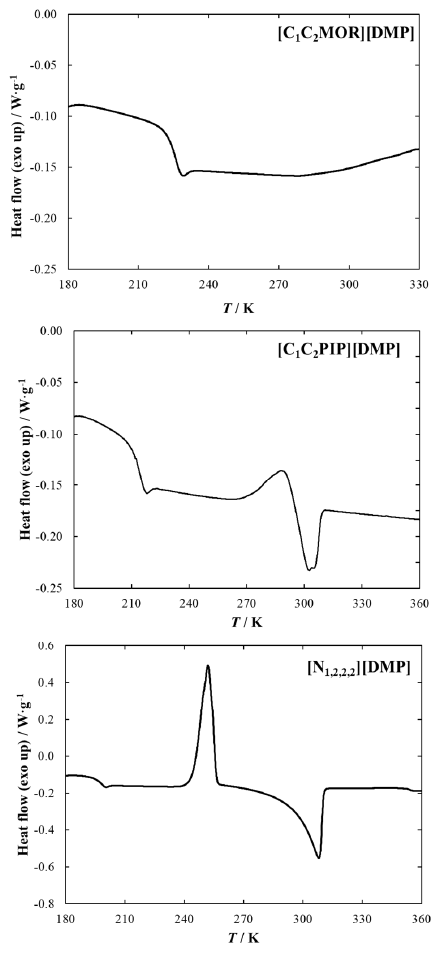
Figure 1. DSC diagrams (in heating mode) of pure iLs. Table 1. DSC Analysis for the dimethyl ‐ phosphate ‐ based iLs: glass transition temperature, T g/ K,